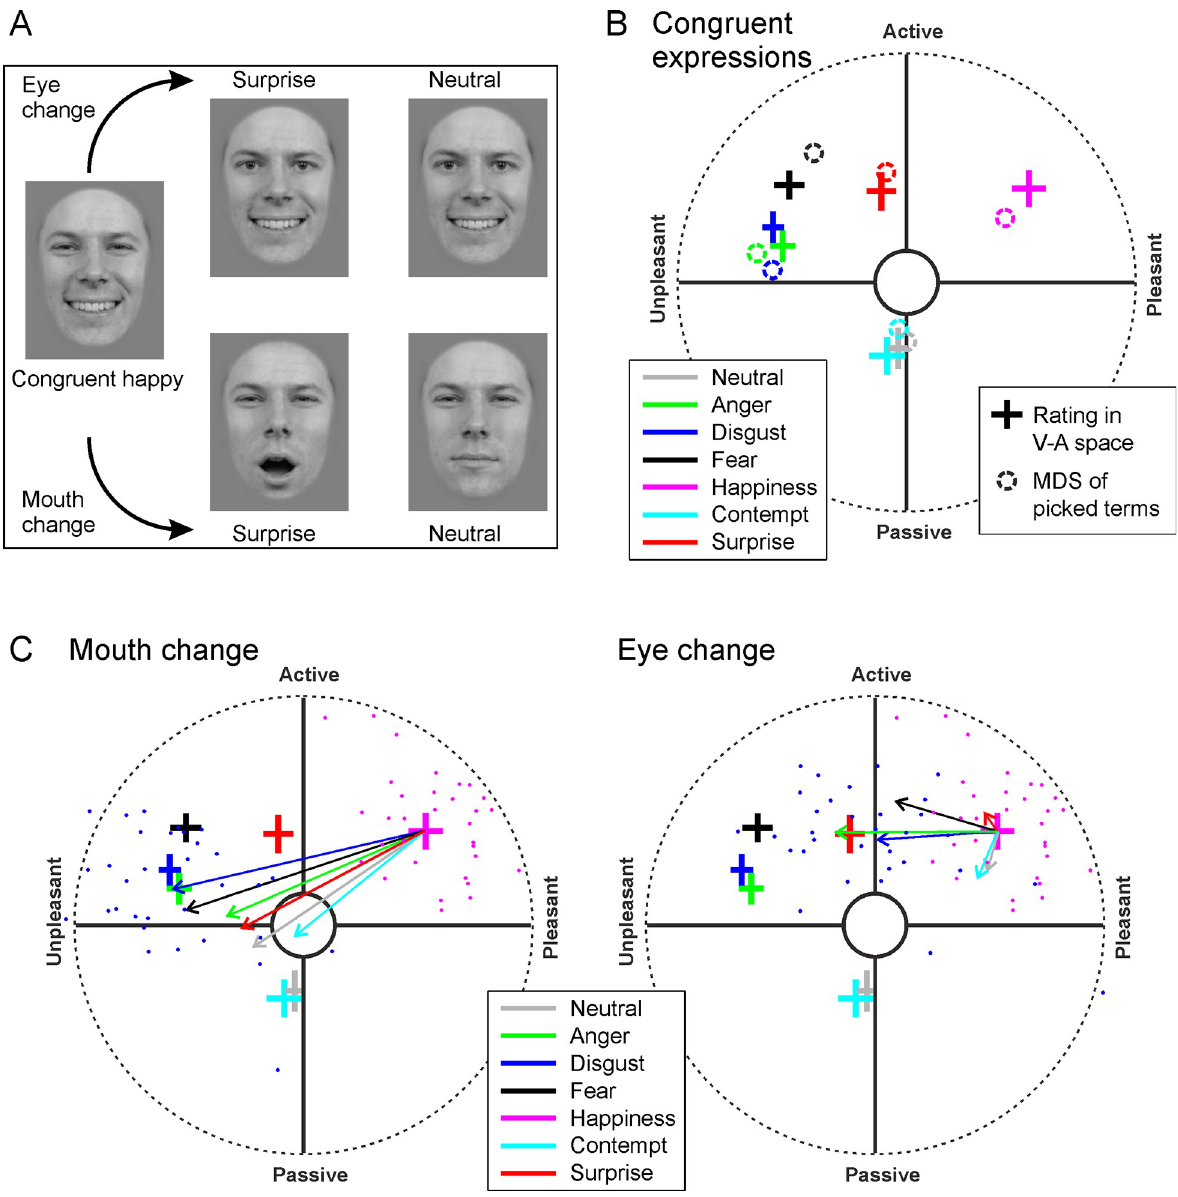
Fig 2. Data from the two measurement methods are in agreement. A) Examples of the congruent and incongruent stimuli used in the experiment. B) Perceptions of congruent emotional expressions as reflected in the direct V-A-ratings (crosses, where the width indicates the 95% CI over participants) and MDS analysis of terms selected from a list (circles). For presentation purposes, the MDS analysis result was transformed, whilst keeping the structure of the data intact (isotropically scaled and rotated). Our simulations (10 000 randomizations) showed that the probability that such a strong correspondence (as indicated by sum of squares of location differences) between the structures of the rating data and the MDS analysis would occur by chance is very low (p < 0.001). C) Examples of changes in the perception when either the mouth (left) or eye (right) region was changed from the congruent expression. The point of the arrow indicates the point to which perception on average shifted in the V-A space. For example, when mouth was changed from happy to disgusted (left), whilst the eyes remained happy, perception shifted quite completely to a point corresponding to the perception of congruent disgust (long blue arrow originating from the magenta cross). Each small dot represents the average of one participant’s ratings in corresponding conditions (magenta: congruent happy, blue: mouth (left) or eyes (right) changed to